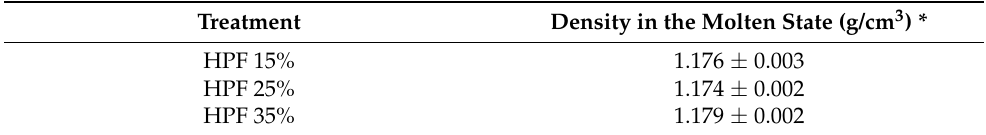
Table 4. Density values in the fade